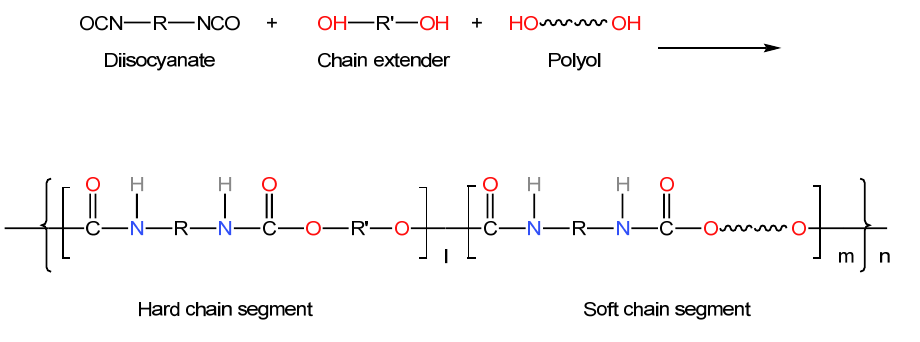
Figure 2. Reaction to form amino ester group. Table 2. Tensile strength and self-repair efficiency of samples with different mass fractions of disulfide.